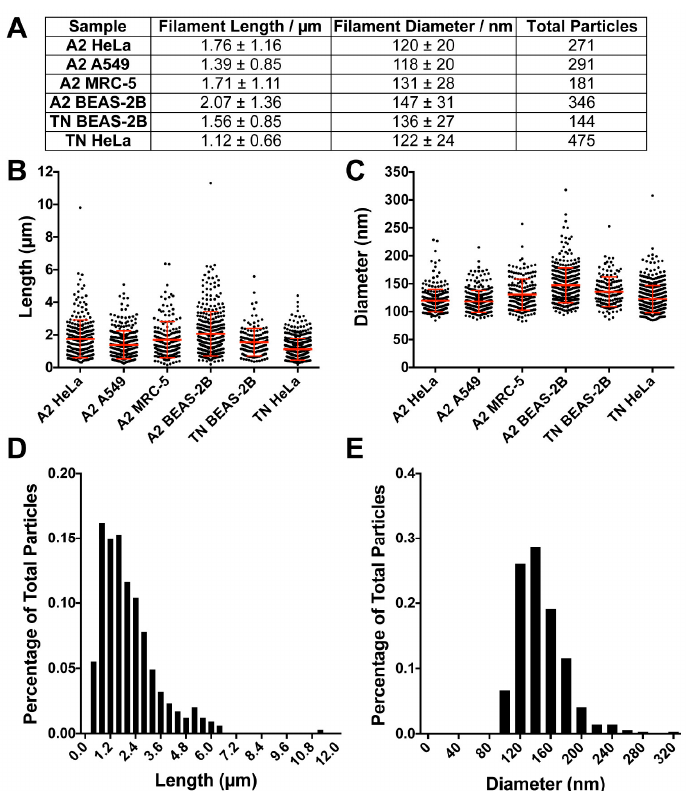
Figure 4. RSV morphology quantification in multiple virus strains and infected cell lines. ( A ) Overall quantification of RSV filament length and diameter. ( B ) RSV filament length distribution in indicated virus-infected cells. ( C ) RSV filament diameter distribution. Note, the mean diameter of RSV filaments is around ~130 nm. ( D , E ) Filament length ( D ) and diameter ( E ) distribution from A2-infected BEAS-2B cells.